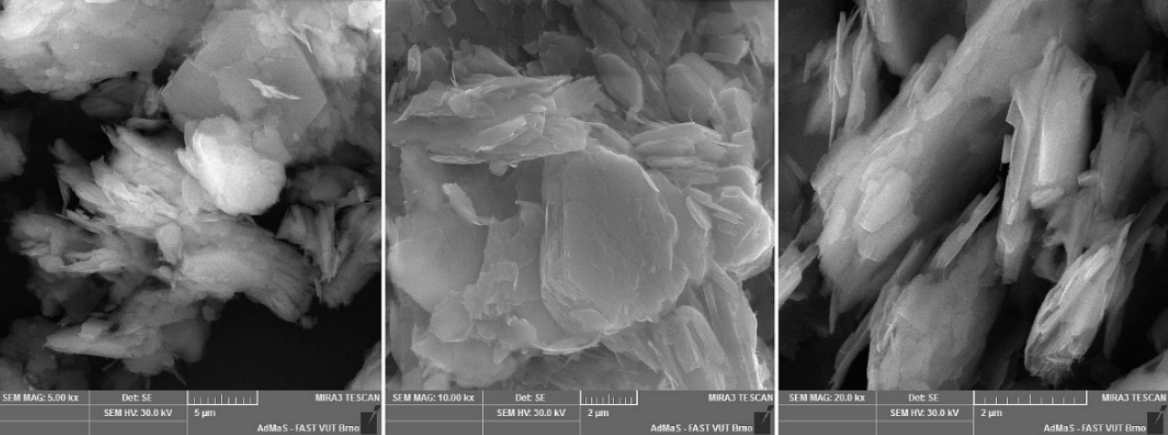
Figure A4. DS1 floated kaolin.